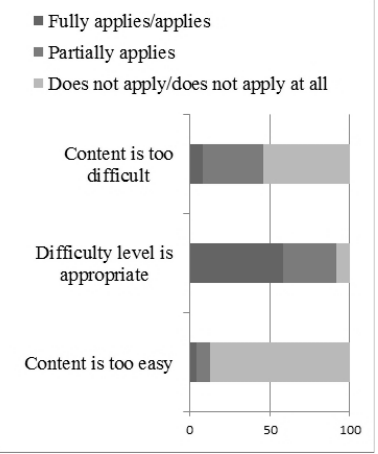
Figure 6. Cateogory: difficulty of the preparatory